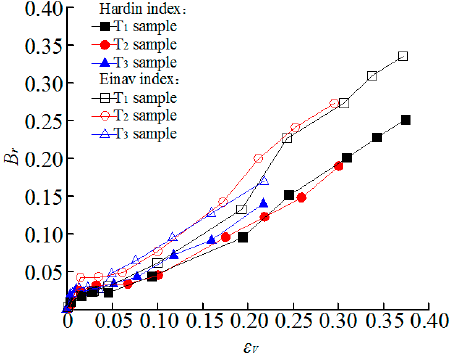
Figure 10. Influence of volumetric strain on relative breakage.